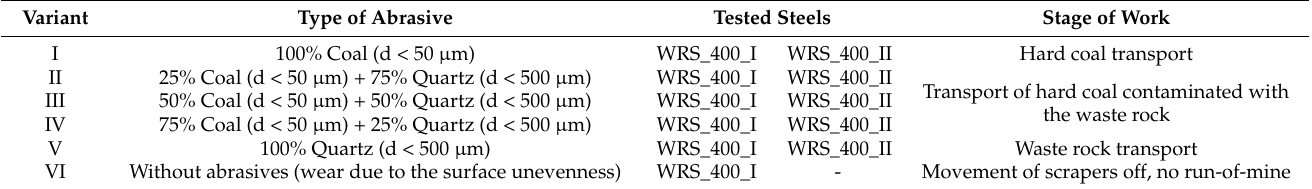
Table 1. Tested variants of abrasives.